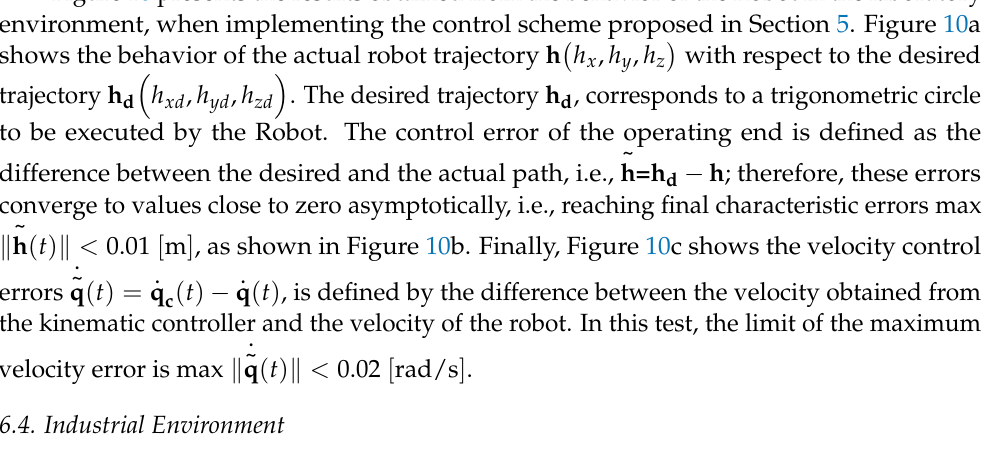
Table 1. Desired task and initial parameters.